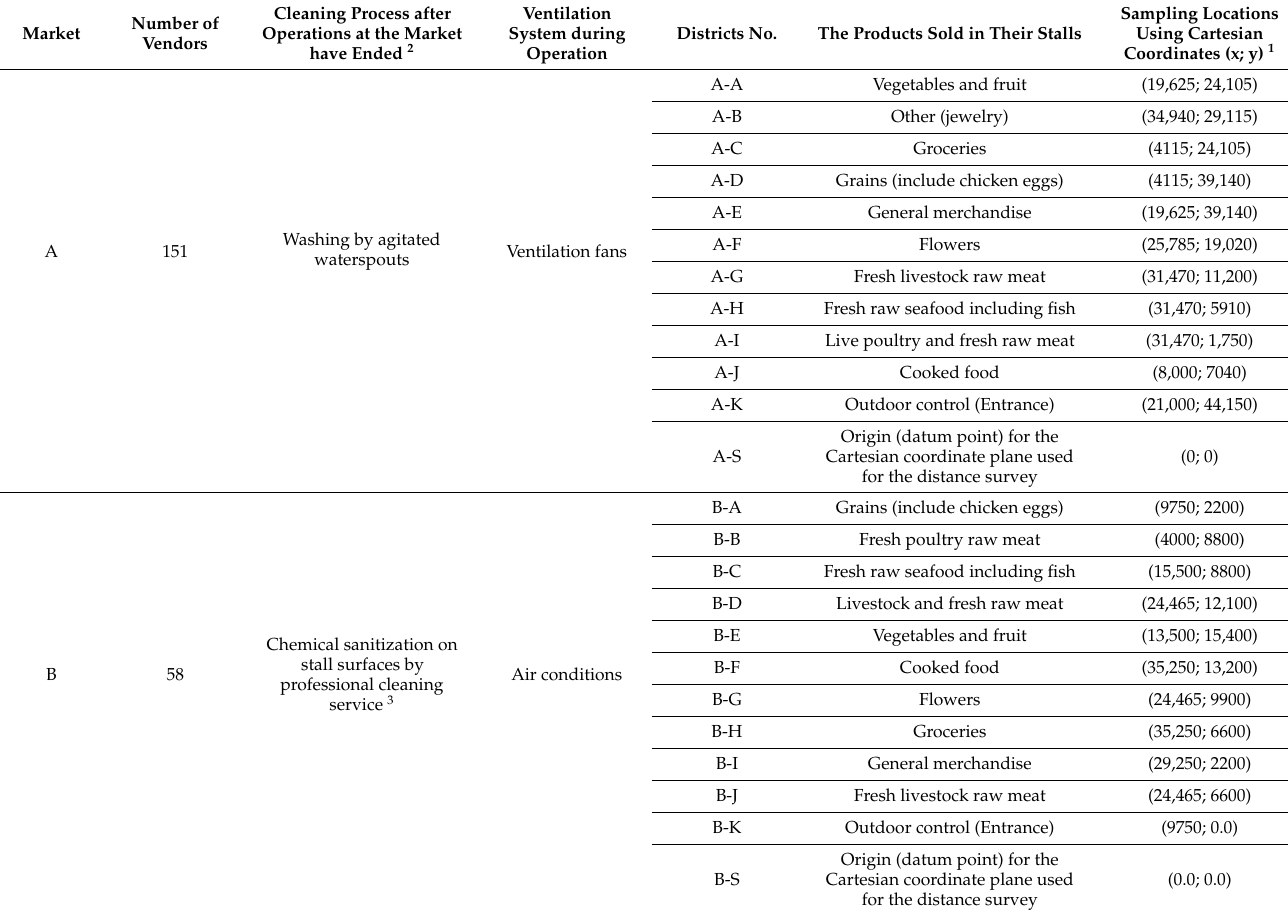
Table 1. Districts of sampling locations within the indoor traditional wet markets